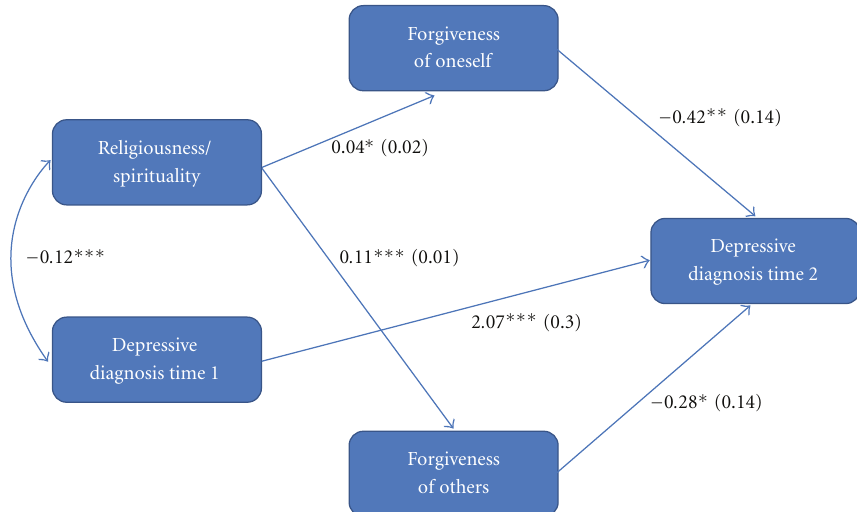
Figure 1: Path analysis of the prospective e ff ects of religiousness/spirituality and prospective mediating e ff ects of forgiveness on depression. Paths from religiousness/spirituality to forgiveness of oneself and others are unstandardized ordinary least-squares regression coe ffi cients (standard errors). Paths from forgiveness of oneself and others to depression are standardized logistic regression coe ffi cients (standard errors). All coe ffi cients are net of the e ff ects of gender, age, race, education, income, and marital status. R 2 = . 32 for depression at time 2. Listwise N =